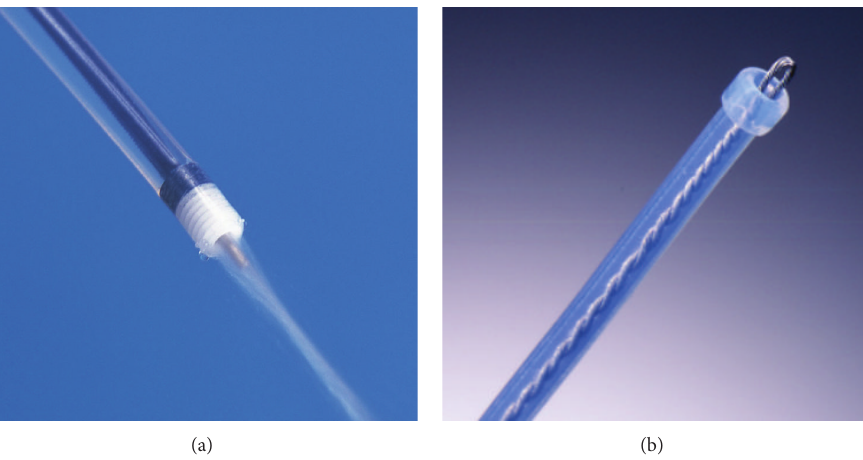
Figure 1: Electrosurgical endoknives used in our study. (a) The Flexknife is a flexible tool that enables endoscopists to adjust the projection length of the tip when needed and is not combined with a water-jet function. (b) The Flushknife is a short needle electrosurgical endo-knife combined with a water-jet